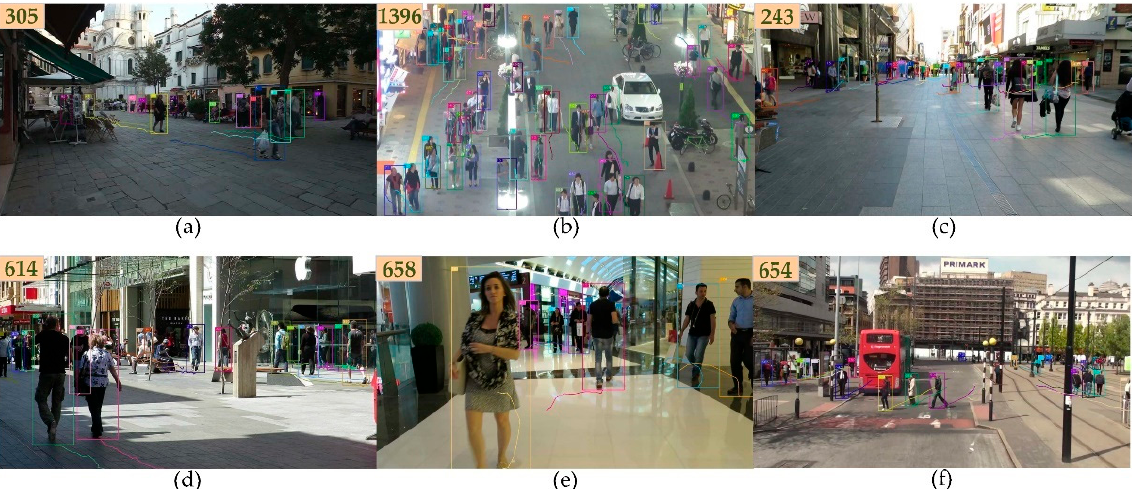
Figure 9. Tracking results of SORT-YM on MOT-16 dataset. The number in the upper left corner represents the frame number of the image. ( a ) MOT-16-01. ( b ) MOT-16-03. ( c ) MOT-16-07. ( d ) MOT-16-08. ( e ) MOT-16-12. ( f ) MOT-16-14.